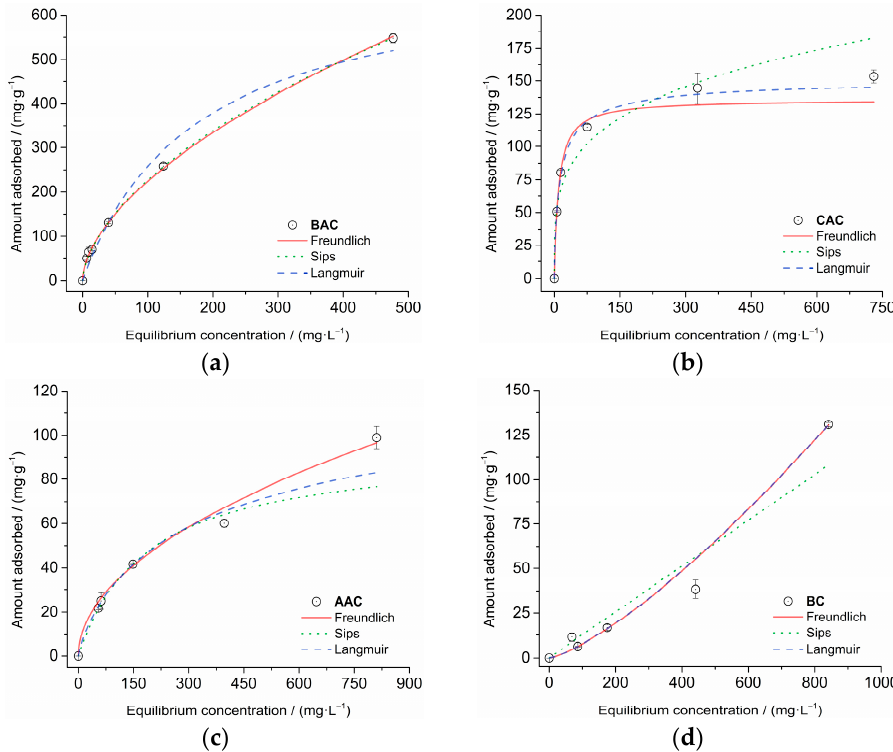
Figure 3. Comparison between predicted values by Langmuir, Freundlich, and Sips isotherm models and experimental data for isoniazid adsorption onto ( a ) BAC, ( b ) CAC, ( c ) AAC, and ( d ) BC.